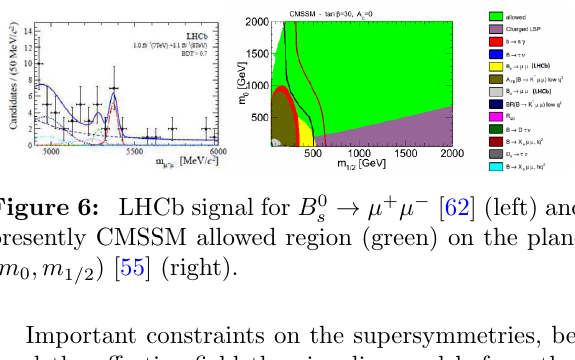
→ µ + µ − [62] (left) and s